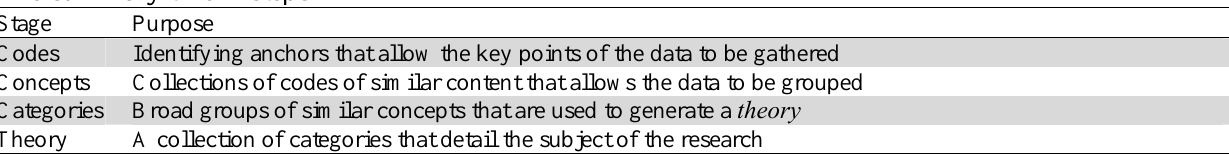
The summary of GT